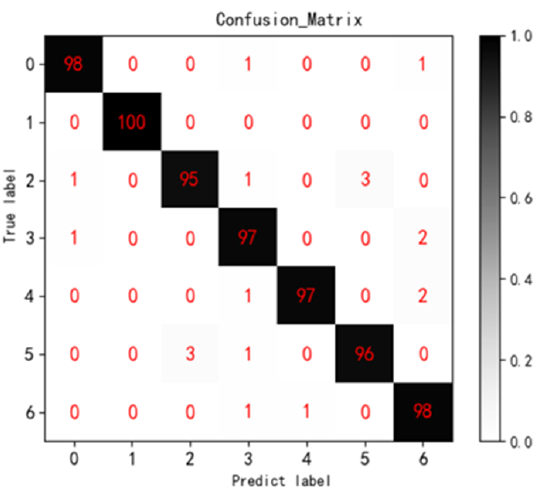
Figure 7. Confusion matrix of recognition results. 0. Tomato bacterial spot; 1. Tomato healthy; 2. Tomato late blight; 3. Tomato leaf mold; 4. Tomato yellow leaf curl virus; 5. Tomato Botrytis cinerea;